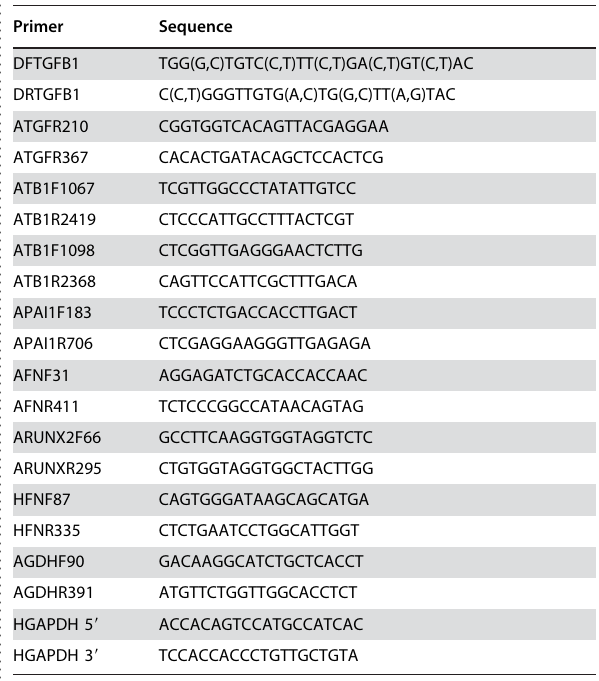
Table 1. Primers used in RT-PCR reactions .. ... .... ... ... .... ... ... .... ... ... .... ... ... .... ... ... .... ... ... ....